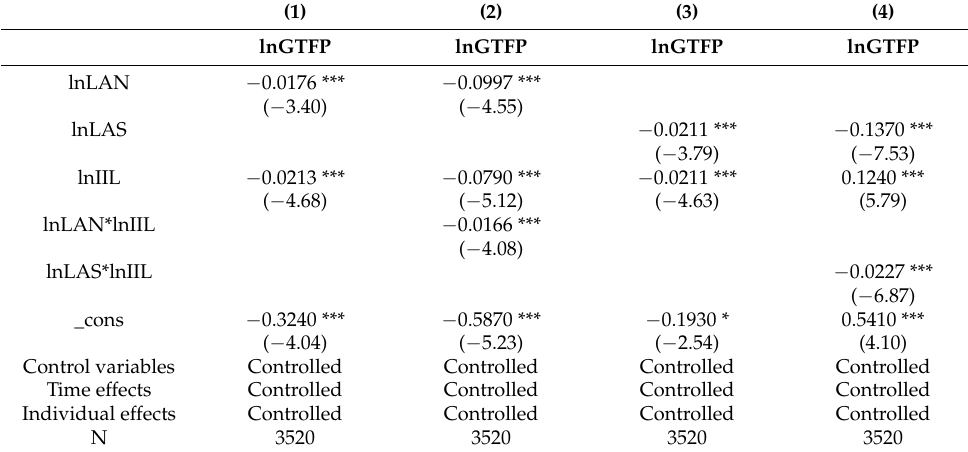
Table 9. Effect of innovation investment level on land market: regulatory effect